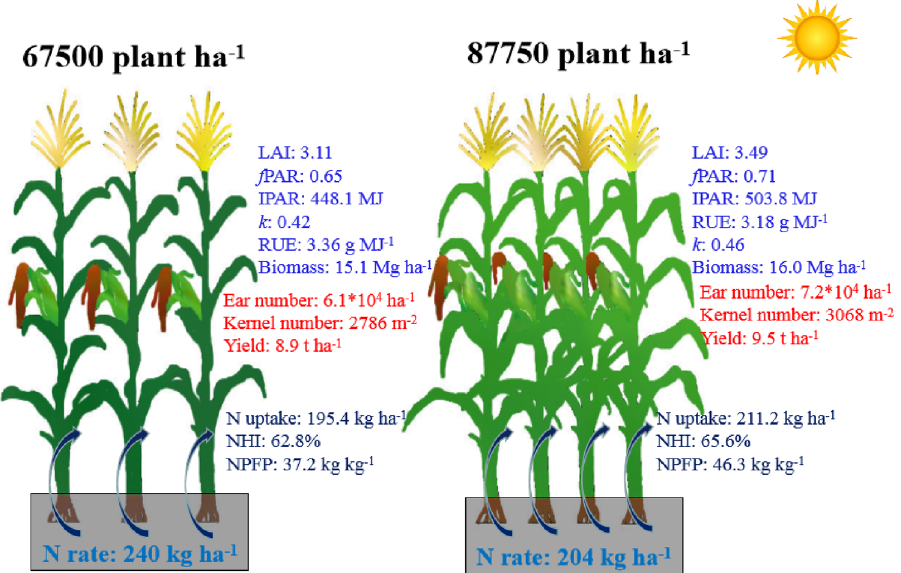
Figure 7. Schematic representation of the processes involved in the canopy development, radiation capture and radiation use efficiency, N uptake and N use efficiency and yield. All data in the figure were averaged by two experiment years. LAI leaf area index, fPAR fraction of PAR intercepted, IPAR cumulative intercepted PAR, RUE radiation use efficiency, k light extinction coefficient, NHI N harvest index, NPFP N partial factor